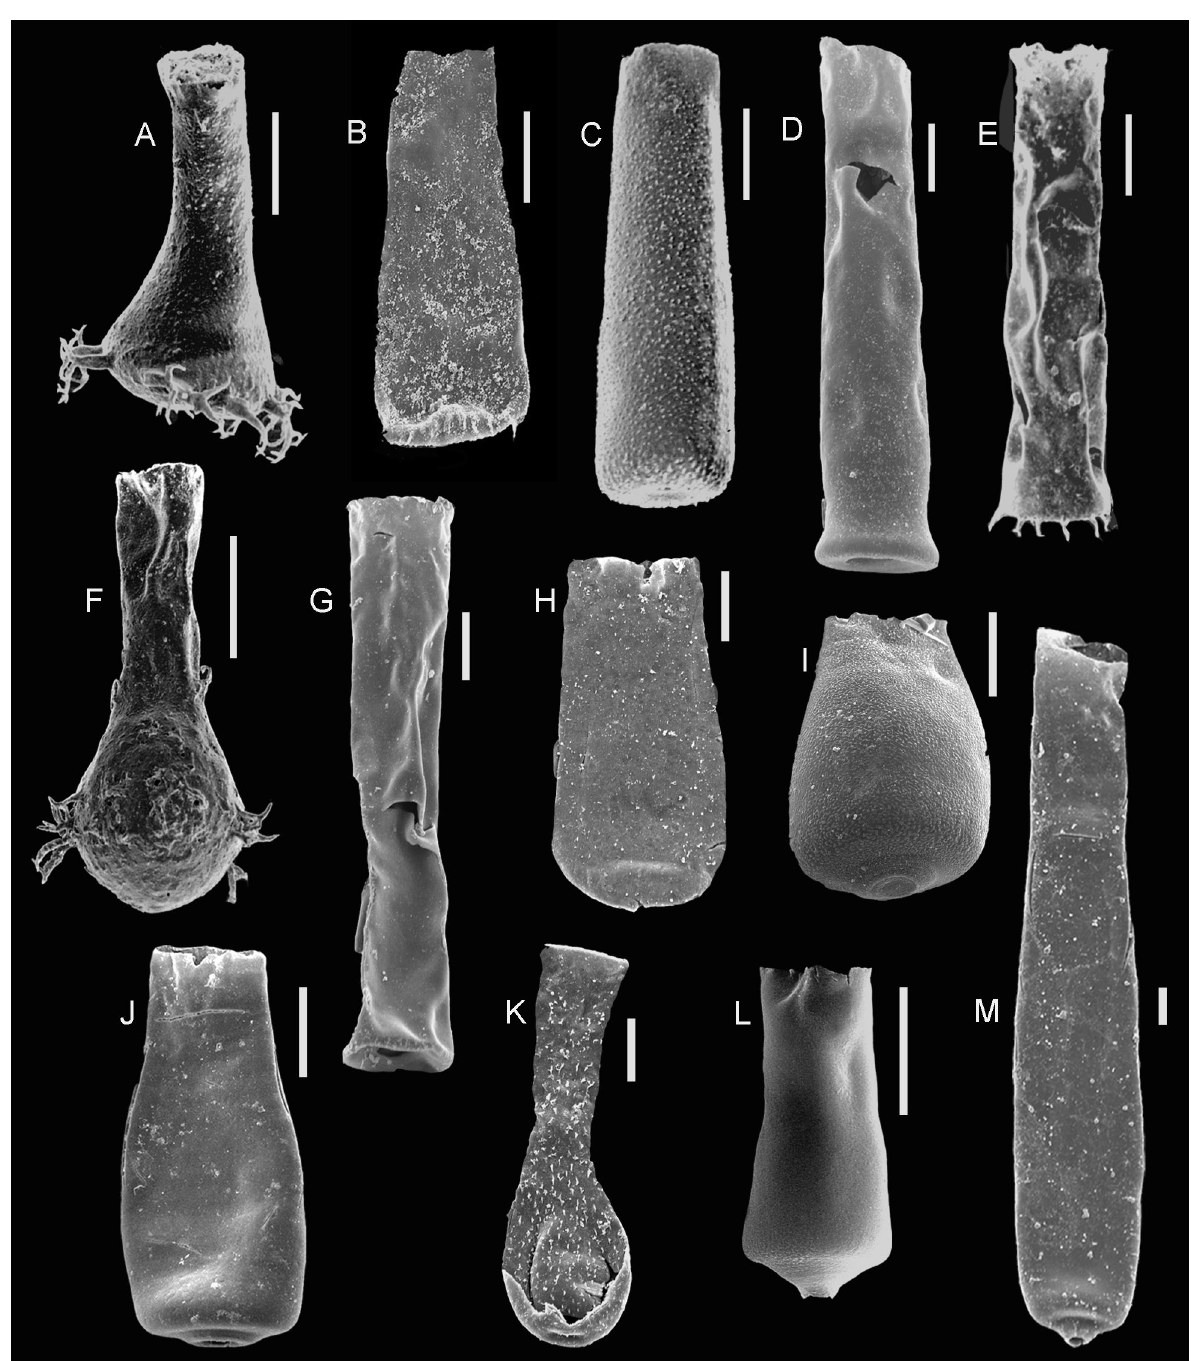
Fig. 4. Chitinozoan biozonal species in the Llandovery of the East Baltic drill cores. Scale 50 (cid:181)m. A , Ancyrochitina laevaensis Nestor, GIT 212-1 (HT), Laeva-10 core, depth 122.5 m, Juuru Stage. B , Spinachitina fragilis (Nestor), GIT 546-3, Kolka-54 core, depth 660.50(cid:150)661.0 m, Juuru Stge. C , Belonechitina postrobusta (Nestor), GIT 212-10 (HT), Ikla core, depth 515.70 m, Juuru Stage. D , Euconochitina electa (Nestor), GIT 546-6, Kolka-54 core, depth 643.0(cid:150)643.30 m, Raikk(cid:252)la Stage. E , Spinachitina maennili (Nestor), GIT 213-3 (HT), Ikla core, depth 462.90 m, Raikk(cid:252)la Stage. F , Ancyrochitina convexa Nestor, GIT 213-1 (HT), Ruhnu core, depth 536.0 m, Raikk(cid:252)la Stage. G , Conochitina alargada Cramer, GIT 546-11, Kolka-54 core, depth 618.10(cid:150)618.50 m, Raikk(cid:252)la Stage. H , Conochitina malleus Van Grootel ( nomen nudum ), GIT 546-18, Kolka-54 core, depth 614.60(cid:150)614.65 m, Raikk(cid:252)la Stage. I , Eisenackitina dolioliformis Umnova, GIT 4272-2, Kaugatuma core, depth 246.45(cid:150)246.55 m, Adavere Stage. J , Conochitina emmastensis Nestor, GIT 423-17, Ventspils D-3 core, depth 815 m, Adavere Stage. K , Angochitina longicollis Eisenack, GIT 546-33, Kolka-54 core, depth 584.90(cid:150)585.20 m, Adavere Stage. L , Conochitina acuminata Eisenack, GIT 272-62, Ohesaare core, depth 349.40 m, Adavere Stage. M , Conochitina proboscifera Eisenack, GIT 546-44, Kolka-54 core, depth 581.90(cid:150)582.20 m, Adavere